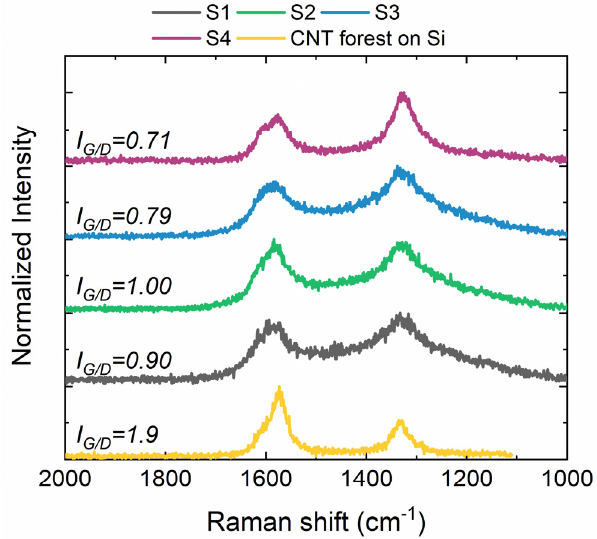
Figure 3. Raman spectra obtained from the CNT forests grown on the different substrates. The I G / D ratio is indicated for every substrate type.